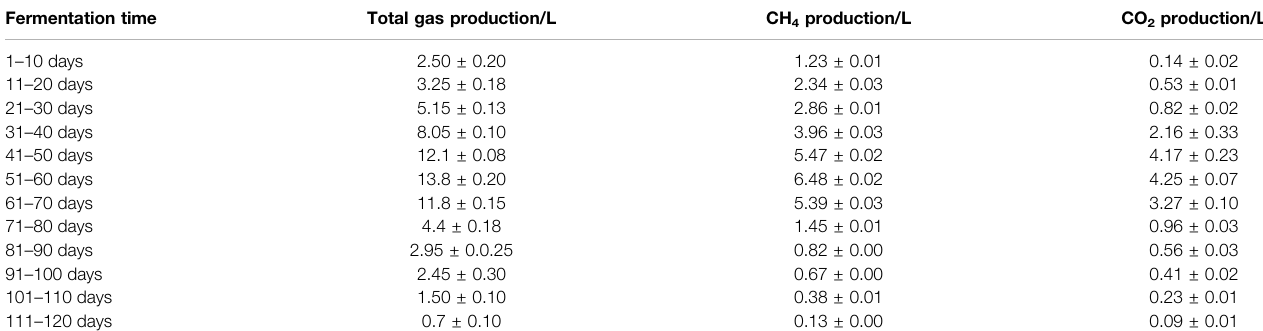
TABLE 2 | Gas production per 10 days.